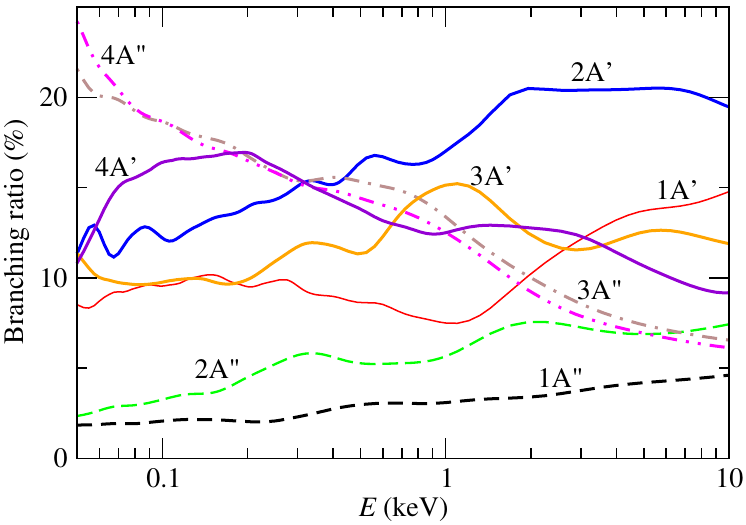
Figure 4. Branching-ratio for production of uracil cations by CT in collisions of protons with uracil molecules. Broken lines correspond to ions in A (cid:48)(cid:48) state, while solid ones are those in a A (cid:48)